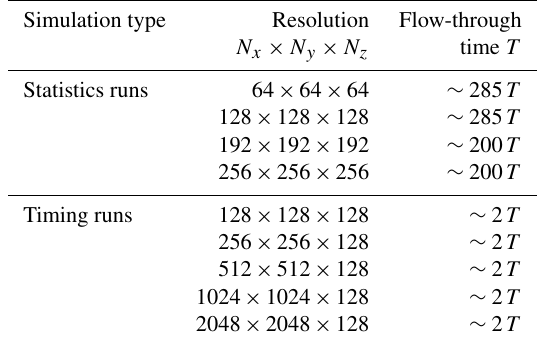
Table 1. Simulations summary, each simulation was run with the three different dealiasing methods.